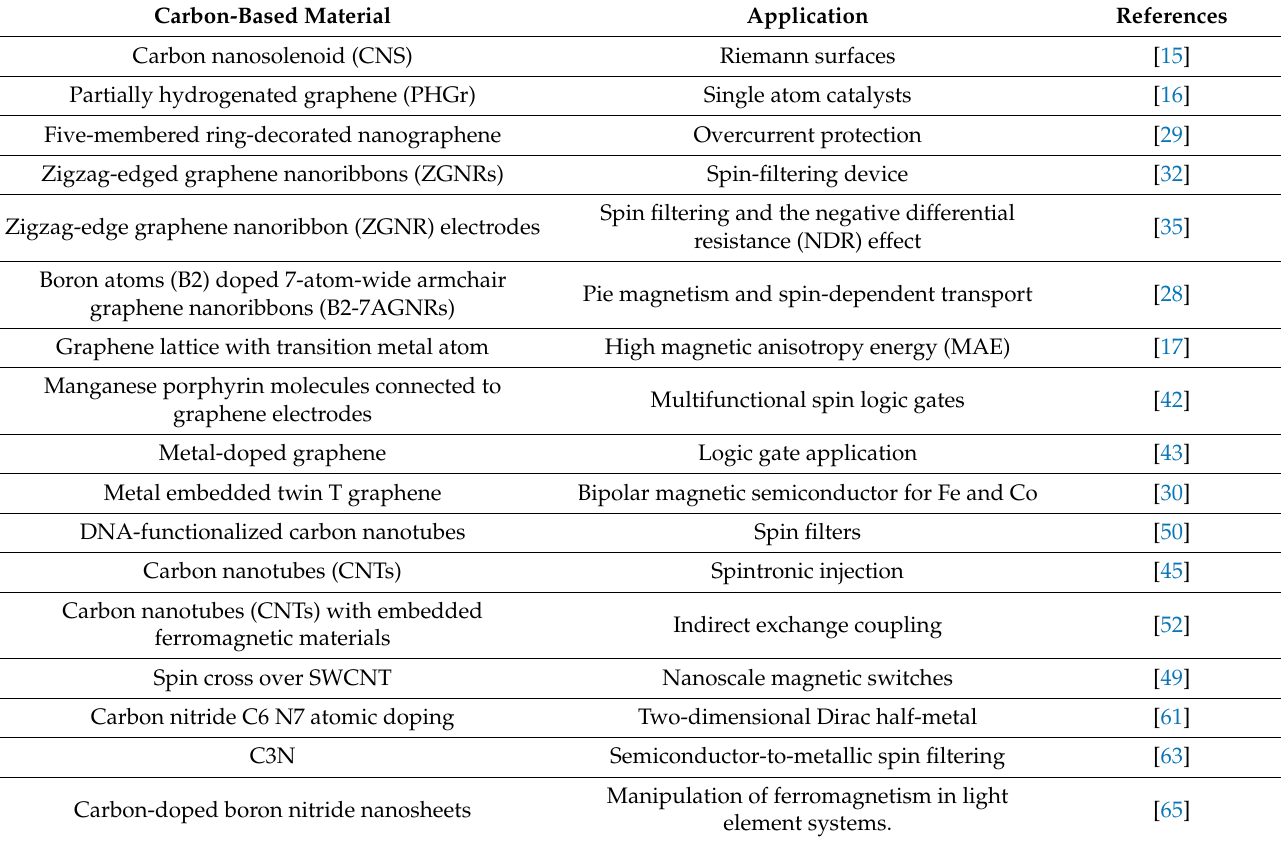
Table 1. Summary of carbon-based spintronic